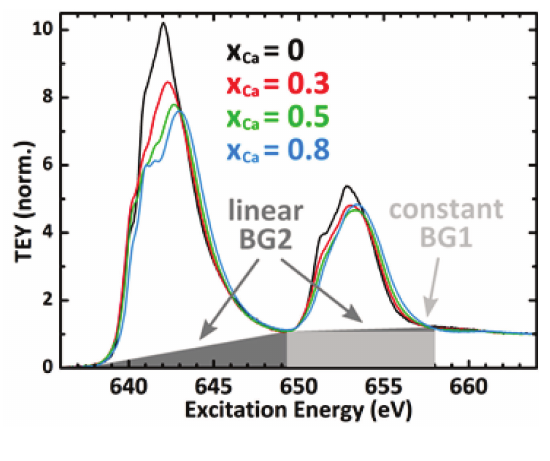
intensities. 3,2